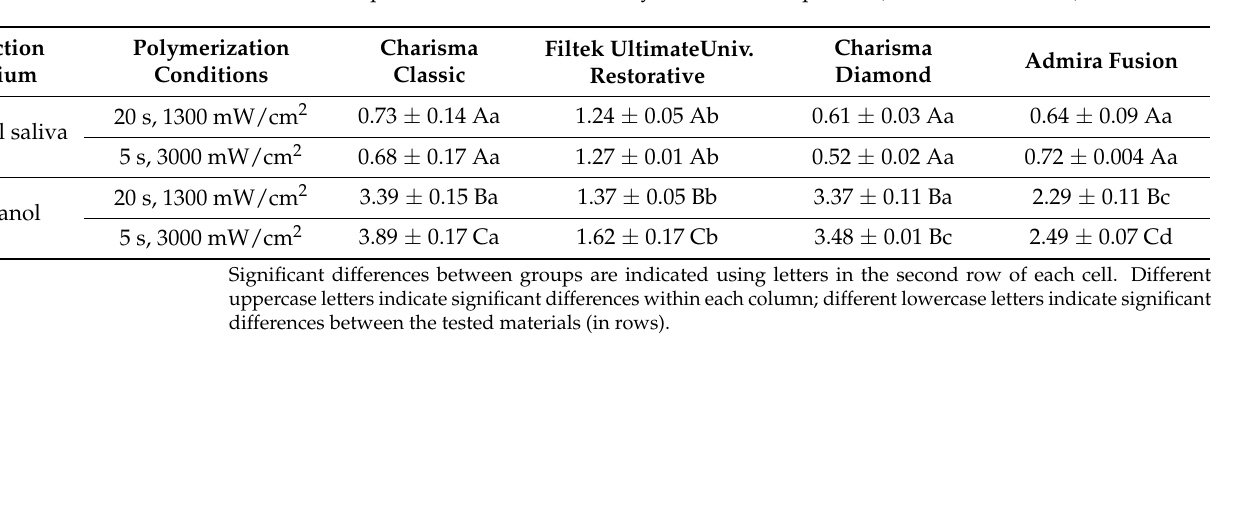
Figure 2. Cumulative amounts of BPA released in the artificial saliva ( black ) and methanol ( red ) plotted against the square root of time. The solid lines represent standard polymerization (20 s, 1300 mW/cm 2 ), whereas dashed lines represent fast polymerization (5 s, 3000 mW/cm 2 ). Table 5. The uptake of extraction media by the tested composites (mean ± SD in wt%).